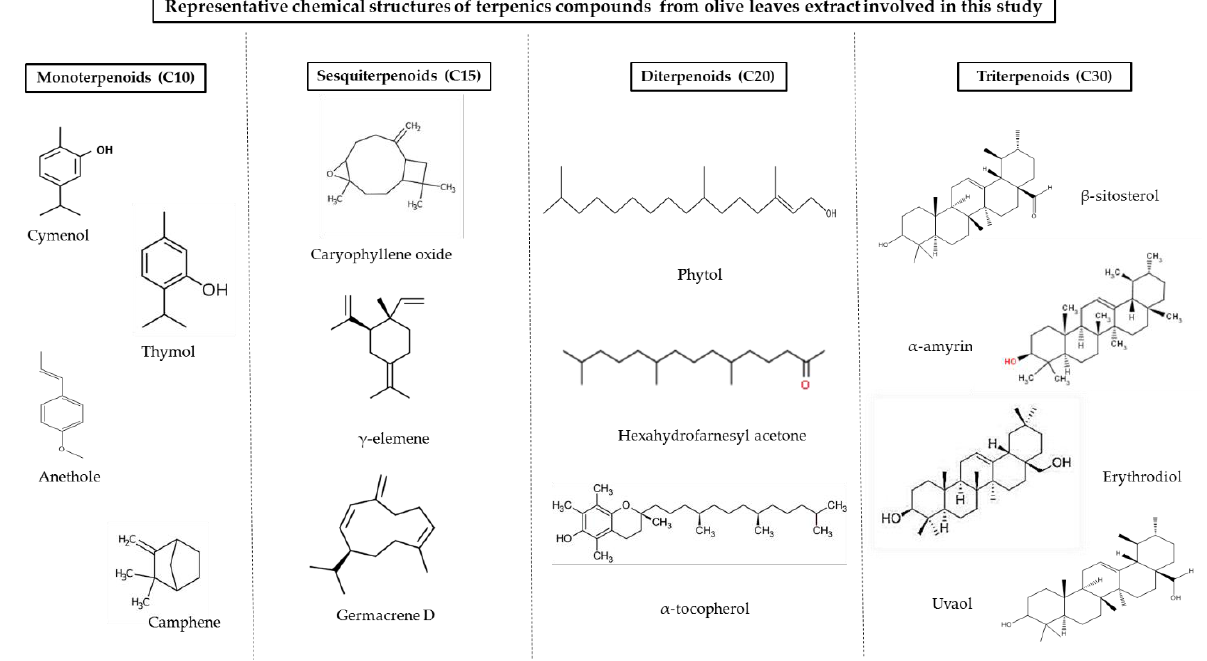
Figure 6. Representative chemical structures of terpenoid compounds from olive leaves extracts